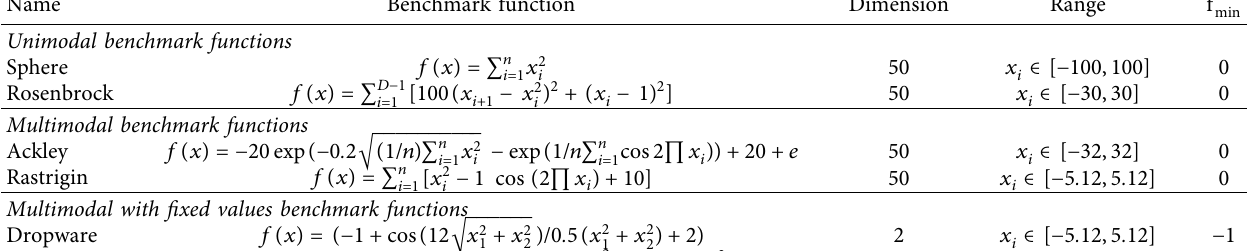
Table 9: Benchmark functions.